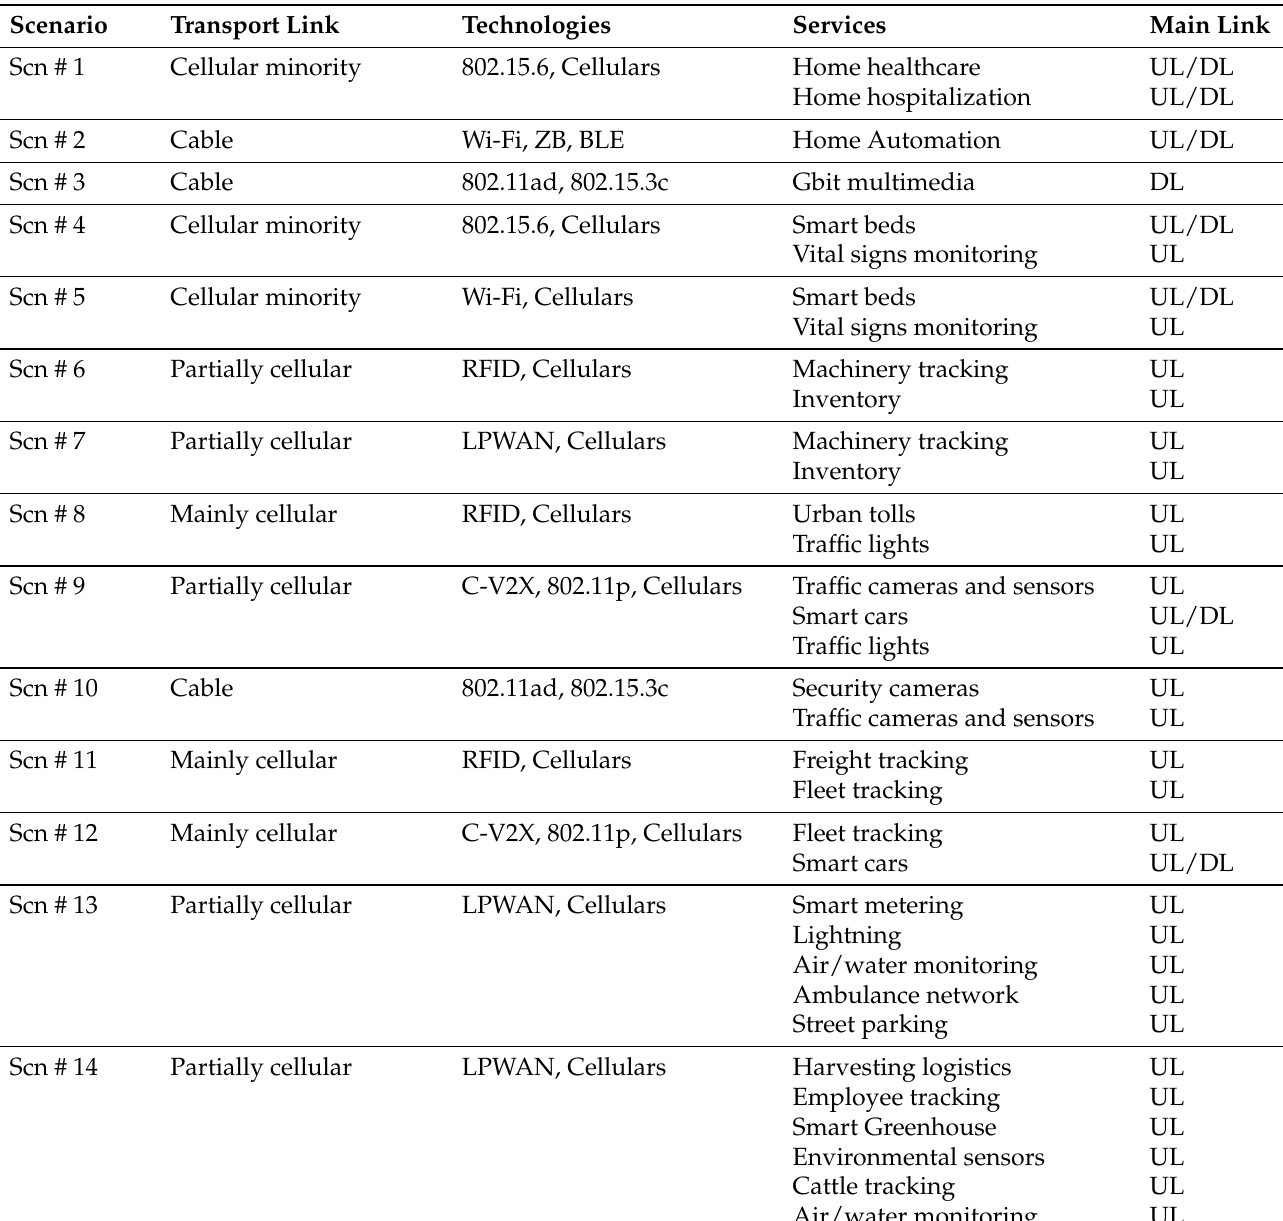
Table 1. A list of services, possible carrier technologies, transport link and the main direction of their access link.